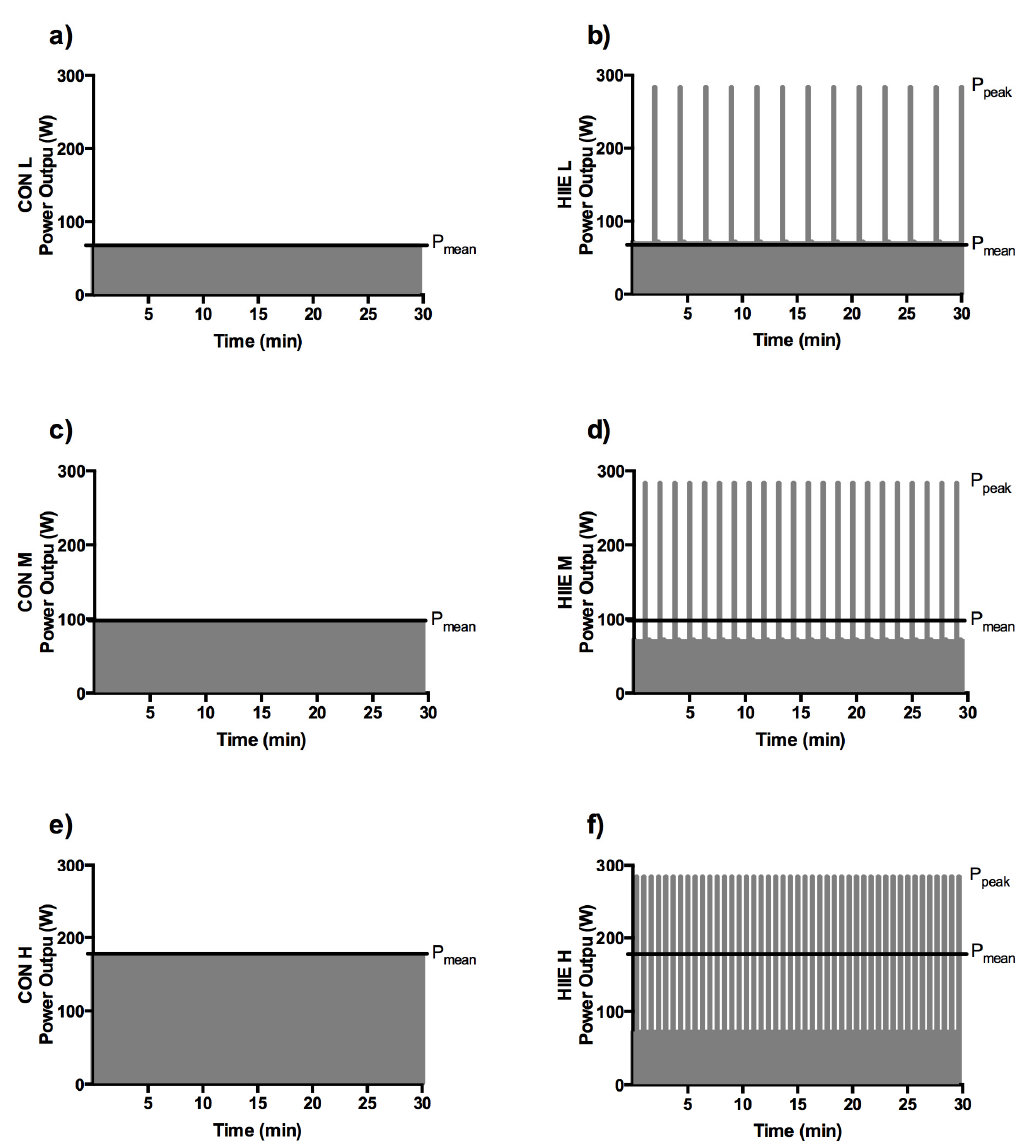
Figure 2. Prescription of the CON L ( a ), M ( c ), H ( e ); and HIIE L ( b ), M ( d ), H ( f ) exercise